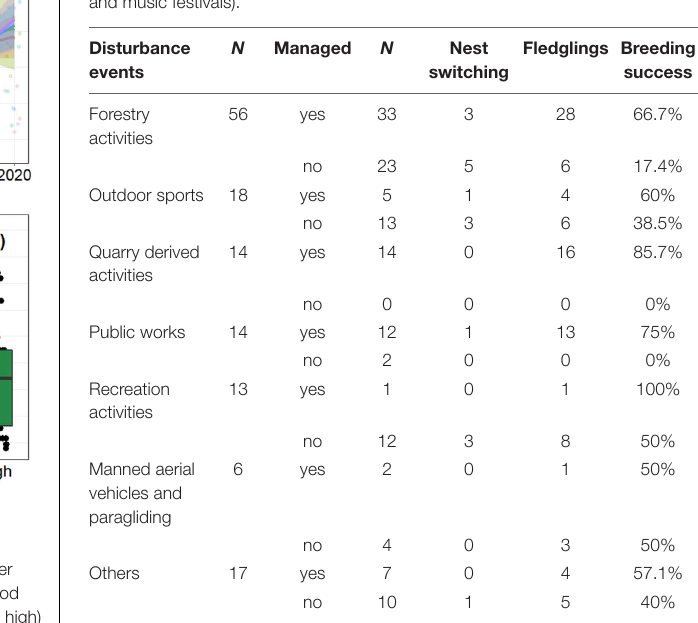
TABLE 3 | Main disturbance events detected within of nest sites of Egyptian vultures during the study period (2000–2020): Forestry activities; quarry derived activities; public works; manned aerial vehicles and paragliding; outdoor sports (climbers, pedestrian, and MTB racers); recreation activities (hikers, mountain bikers, photographers, and birdwatchers); and others (illegal hunting, motorcycles, and music